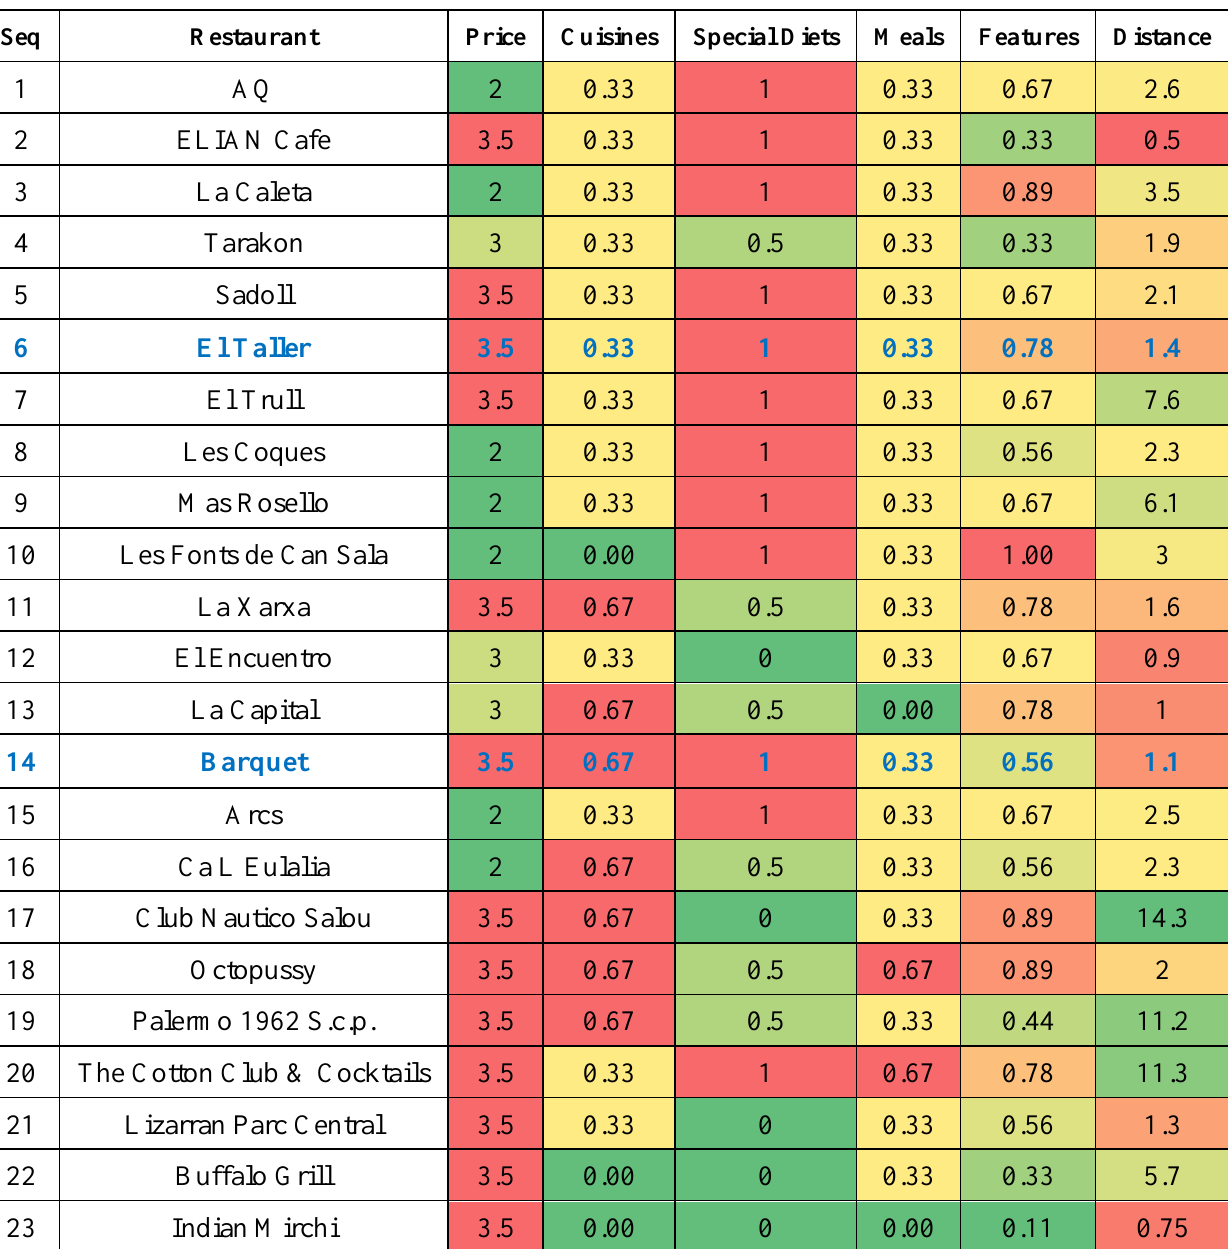
Figure 7. Example 1: domain performance table. The colour indicates the degree of satisfaction, green being the worst and red the